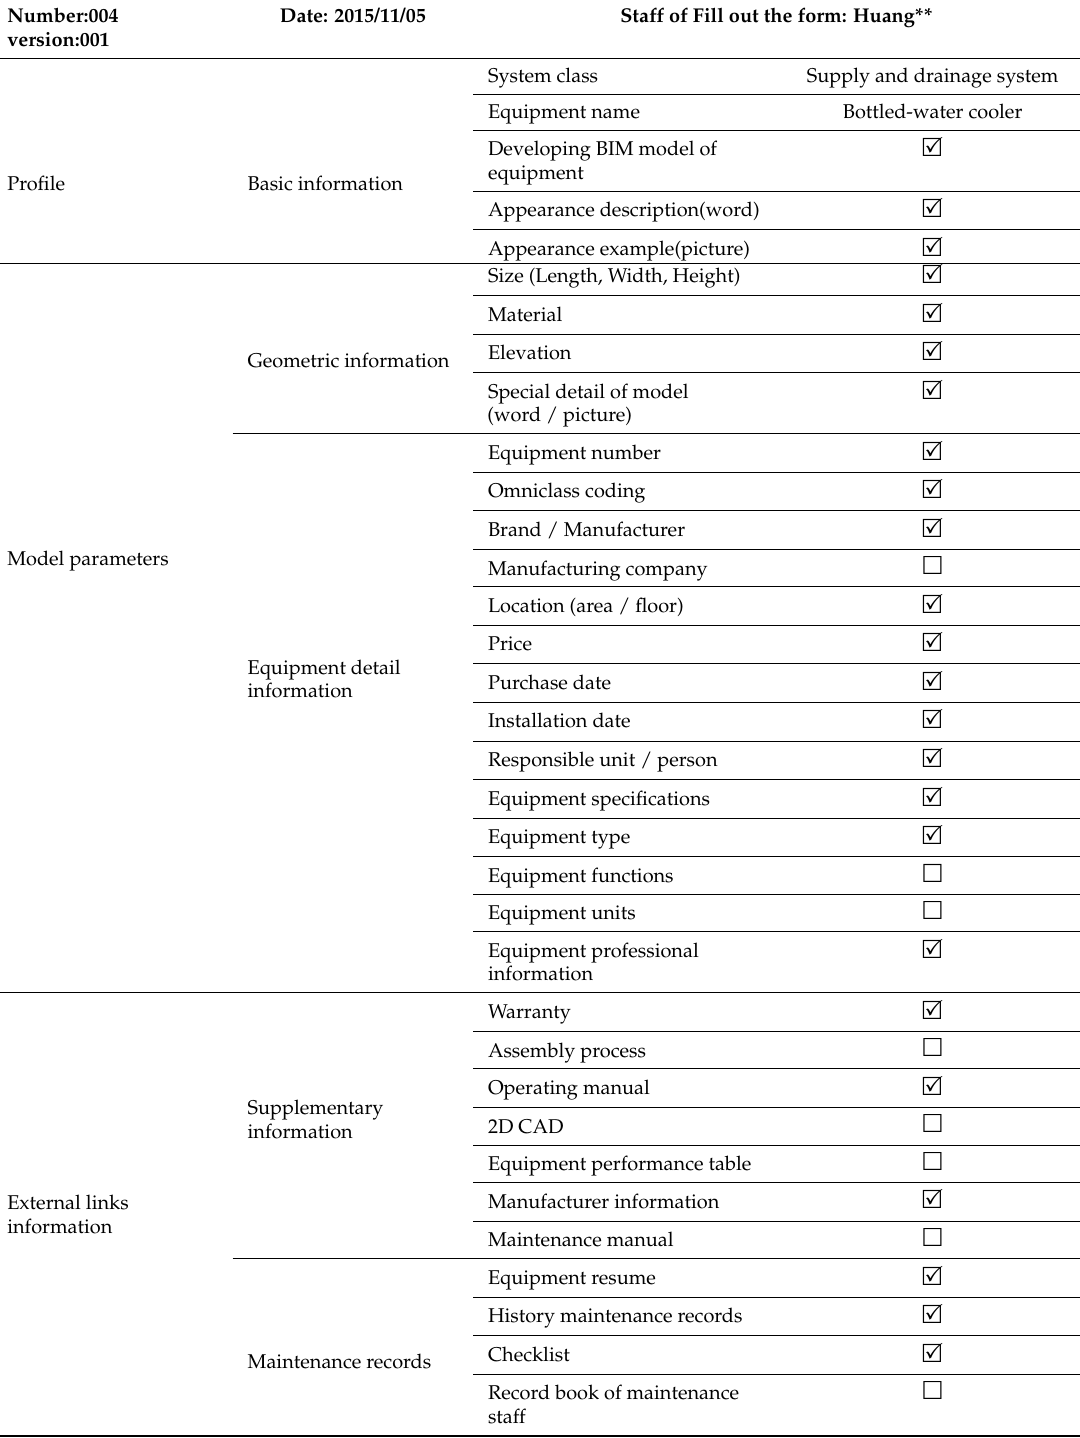
Table 2. The detailed required sheet of BIM model for FM.